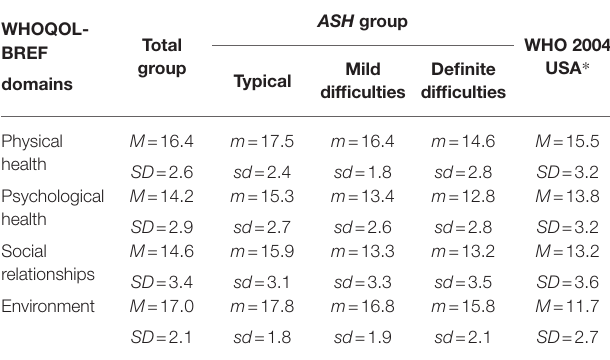
TABLE 2 | Comparison of WHOQOL-BREF domains of adults with known childhood sensory processing challenges and published data. WHOQOL- BREF